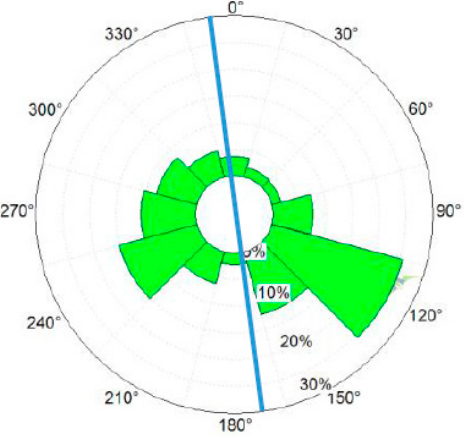
Figure 6. Frequency wind rose of 12 months.